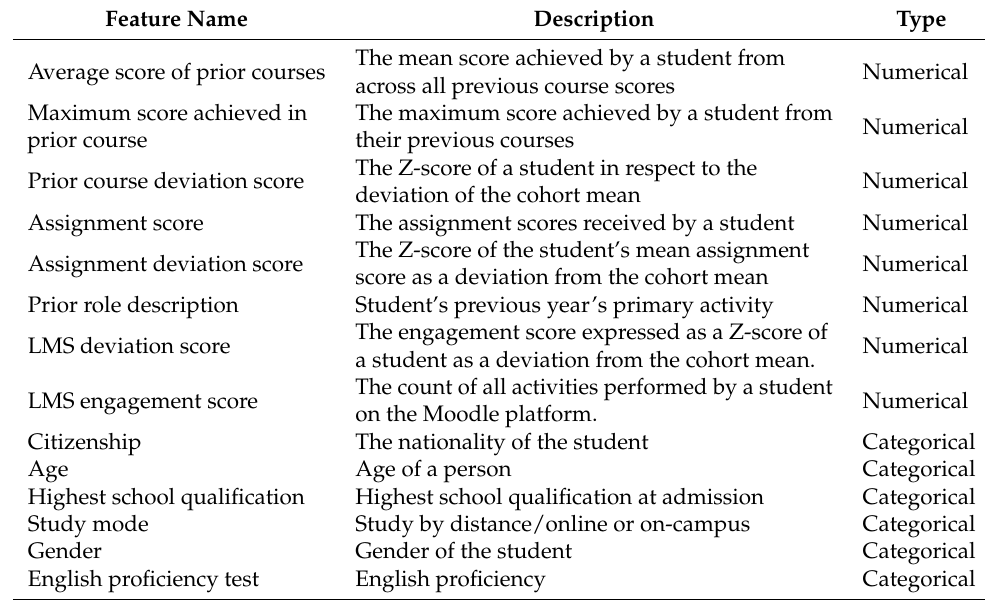
Table 3. Feature